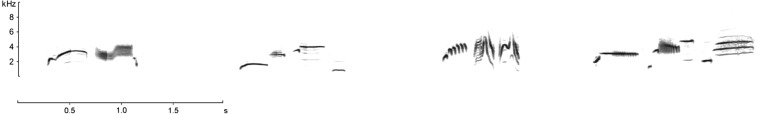
Sonogram of a typical Dupont’s Lark song in the study area.